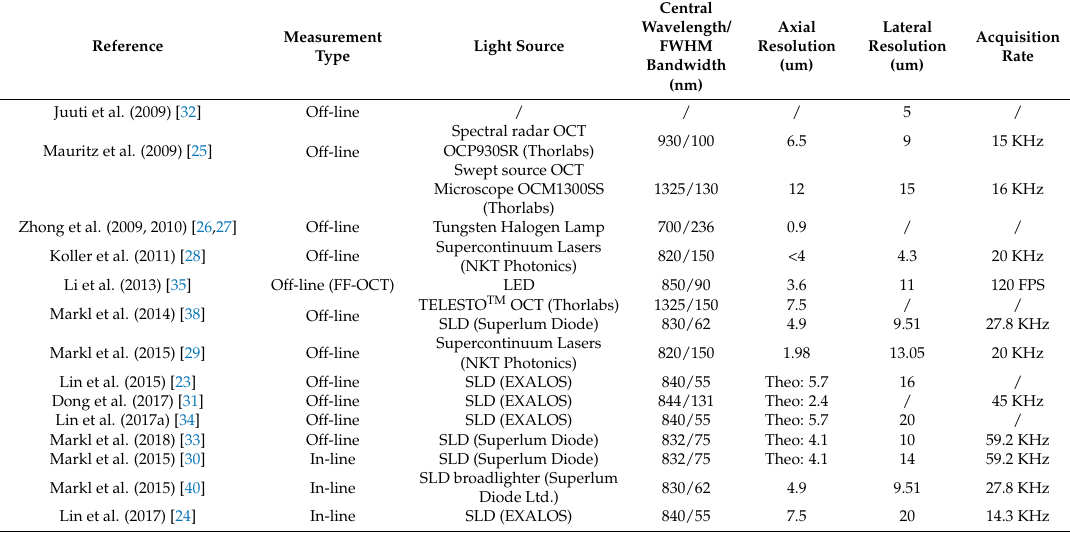
Table 1. Summary of OCT application for characterising pharmaceutical